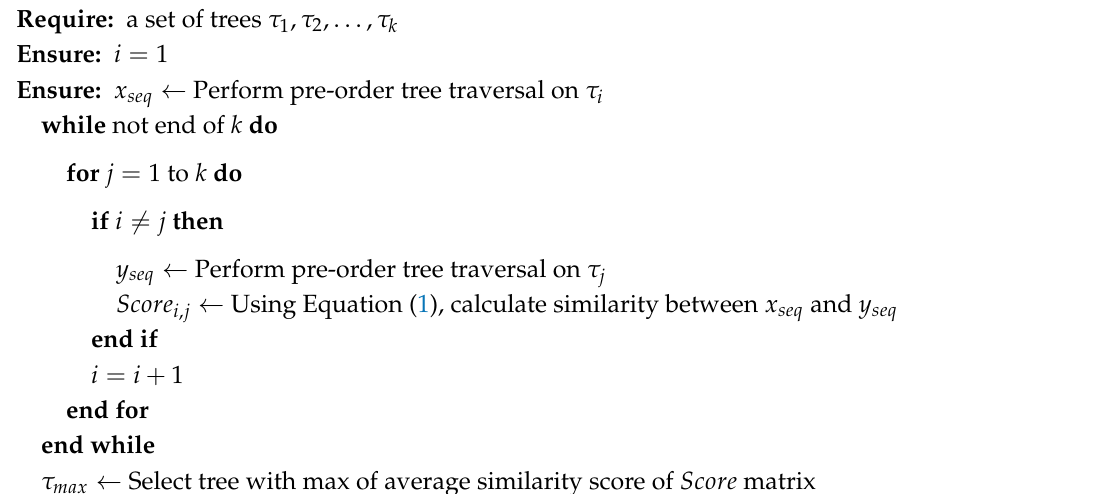
Algorithm 1 shows the steps of using Needleman-Wunsch algorithm for tree alignment. The output is a score matrix containing the alignment score for every pair of trees. This matrix is then used to calculate the average similarity score. Algorithm 1 Tree Alignment Using Needleman-Wunsch